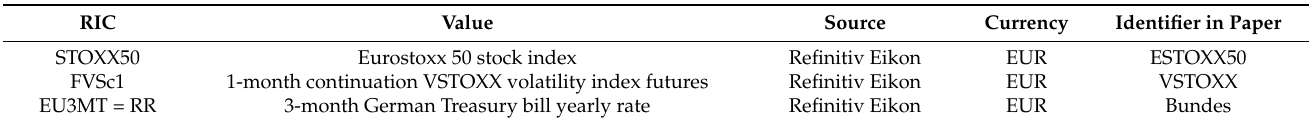
Table 1. The name, description, Refinitiv Identification Code (RIC), currency, and the identifier used in this paper of the three securities used in our